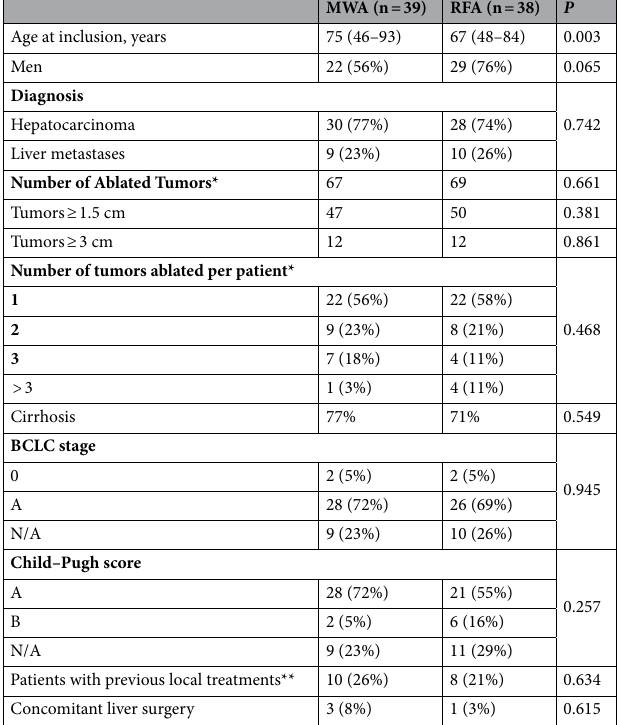
Table 1. Patient data. Data are n (patients), n (%), or the mean (range). *Include all liver tumors ablated during the trial (tumors < 1.5 cm were not considered for analysis). **Include previous liver surgeries or liver ablations; previously treated tumors were not considered for the trial. Analyses are done by patient.